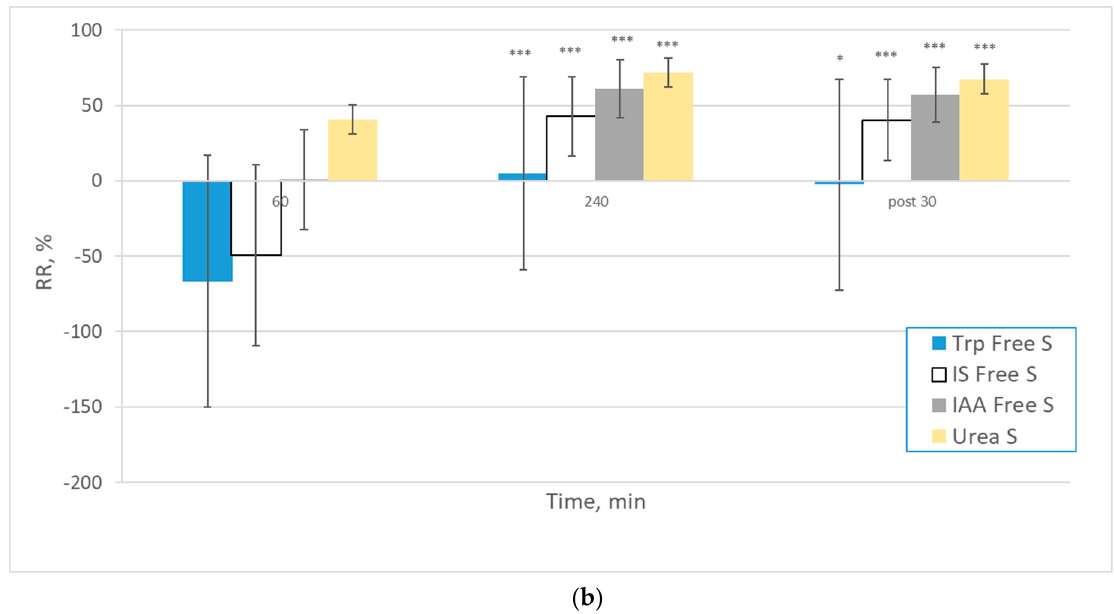
Figure 2. Reduction ratios (RR) at different time points during the dialysis sessions for Trp, IS, IAA and urea calculated from ( a ) total serum values ( n = 309) and ( b ) free serum values ( n = 309). *** p < 0.001; ** p < 0.01; * p < 0.05 vs. previous timepoint value. RR at different time points during the dialysis sessions for Trp, IS, IAA and urea calculated based on the dialysate concentrations are shown on Figure 3.